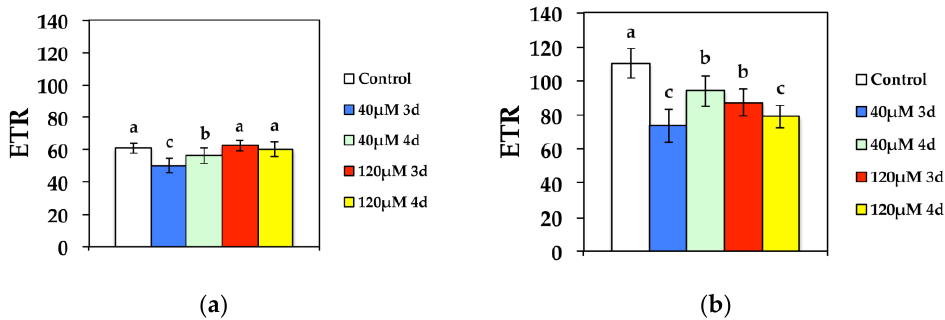
Figure 6. Changes in the relative PSII electron transport rate (ETR) measured at ( a ) 300 μmol photons